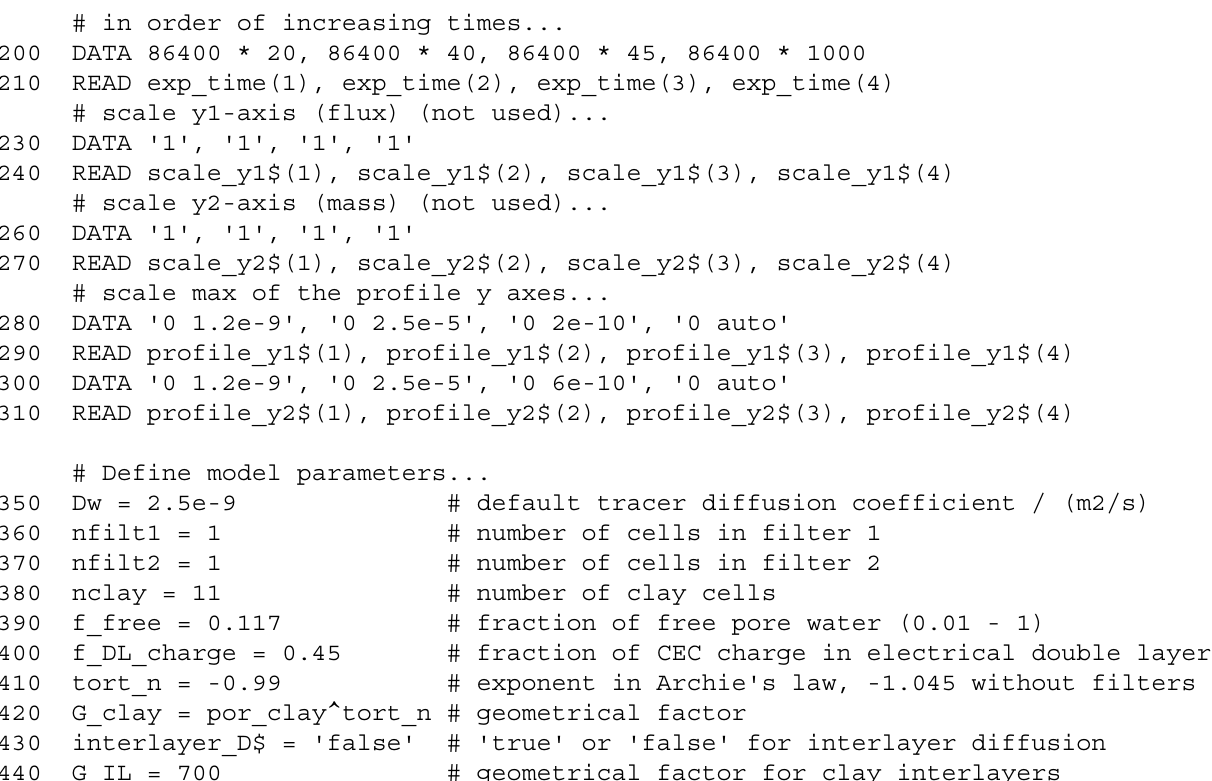
Table 60. Input file for example